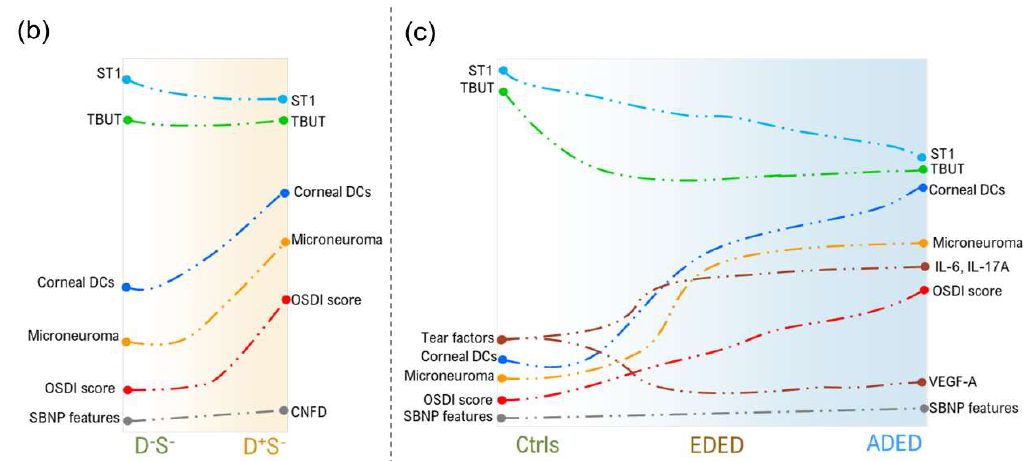
Figure 12. Schematic representation of signs, symptoms, confocal microscopy features, and tear fluid factors in in subjects categorized based on discomfort concordance to signs (DCS), grouping strategy, and dry eye disease types. ( a ) Line graph representation indicate the patterns (based on statistically significant observations) in ocular surface disease index (OSDI) score, tear break up time (TBUT), Schirmer’s test (ST1), corneal dendritic cell (DCs) density, sub-basal nerve plex (SBNP) features, microneuroma-like structures (microneuroma), and tear fluid factors across the different categories based on DCS grouping strategy as described in Figure 1. ( b ) Line graph representation indicate the patterns (based on statistically significant observations) in ocular surface disease index (OSDI) score, tear break up time (TBUT), Schirmer’s test (ST1), corneal dendritic cell (DCs) density, sub-basal nerve plex (SBNP) features, microneuroma-like structures (microneuroma), and tear fluid factors in subjects with discomfort but no signs. D - S - indicates subjects without discomfort/symptoms and signs and D + S - indicates subjects with discomfort/symptoms but no signs. ( c ) Line graph representation indicates the patterns (based on statistically significant observations) in ocular surface disease index (OSDI) score, tear break up time (TBUT), Schirmer’s test (ST1), corneal dendritic cell (DCs) density, sub-basal nerve plex (SBNP) features, microneuroma-like structures (microneuroma), and tear fluid factors in controls and in subjects with evaporative dry eye disease (EDED) or aqueous deficient dry eye disease (ADED). Controls are subjects without discomfort/symptoms and signs (D - S - ).